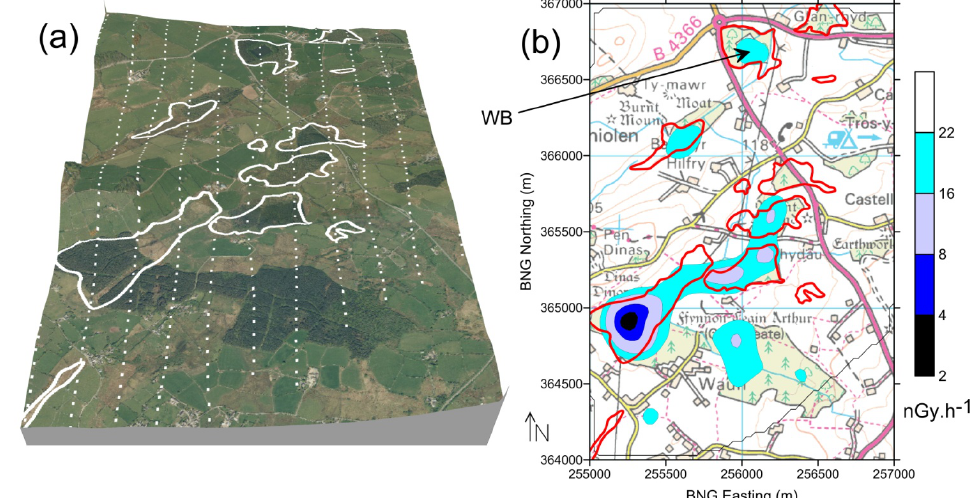
Figure 7. The 2 × 3 km study area (mainland area of Anglesey survey) across an area of afforested peat. ( a ) Perspective view, looking north, of aeriel image draped on DTM, with white dots showing airborne sampling locations. White polygons denote areas of peat. ( b ) 1:50 k base topographic map with colour contours of the radiometic DOSE response limited to values <22 nGy·h − 1 . Red polygons denote areas of peat. WB denotes a water